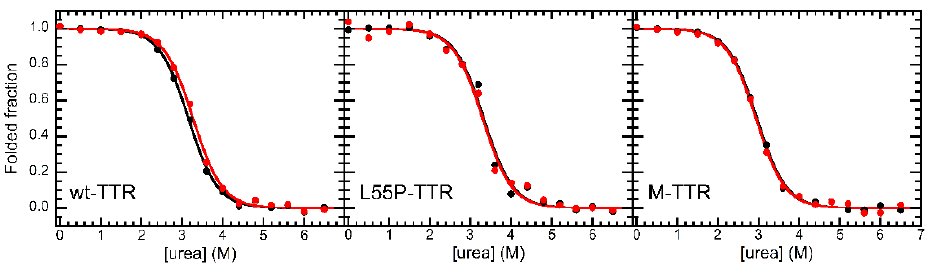
Figure 6. Equilibrium unfolding experiments of TTR in the absence (black) and in the presence (red) of 100 µM OleA. Data reported refer to wt-TTR ( left ), L55P-TTR ( center ), and M-TTR ( right ). Continuous lines represent best fits of data to the model edited by Santoro and Bolen [33].